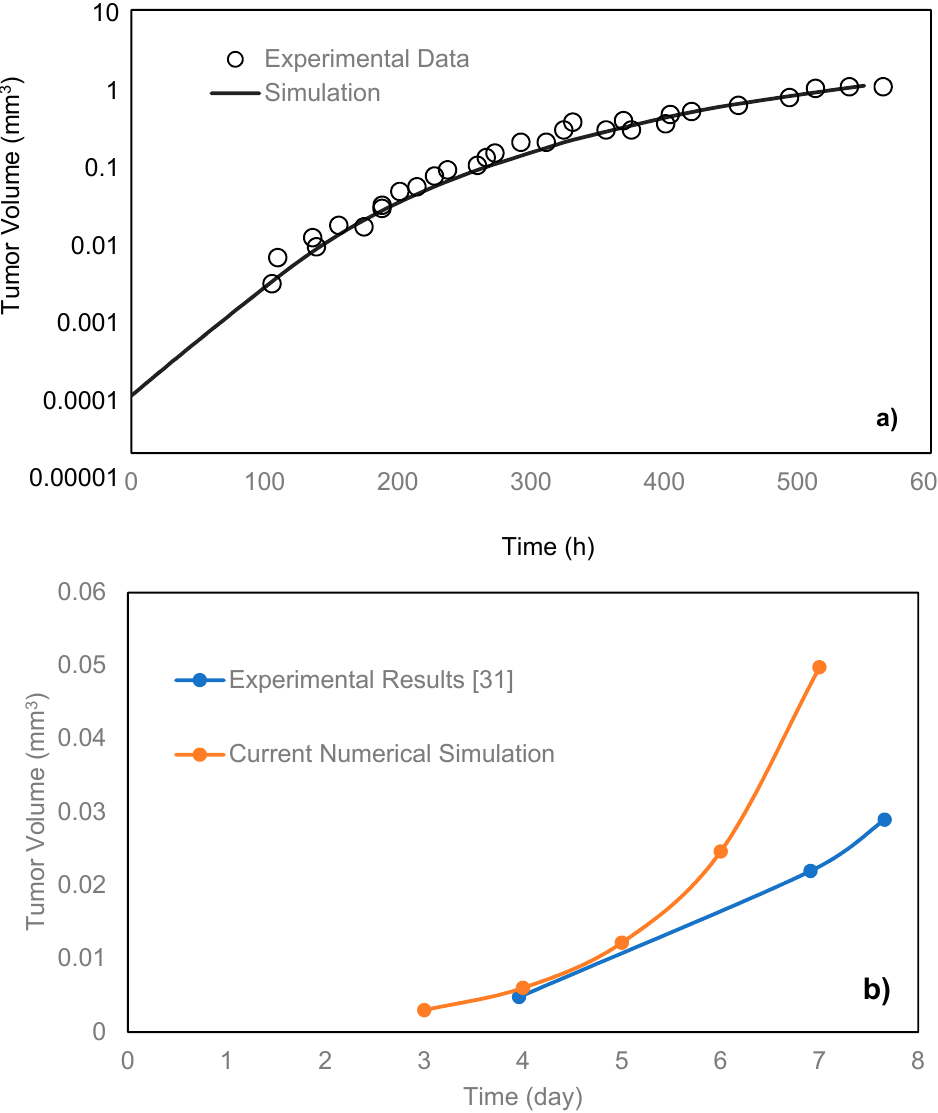
Figure 3. ( a ) Comparison of the tumor volumes from experiment data of the Sutherland and Freyer for EMT6/Ro spheroid [14] and simulation based on the proposed model. In both cases, the tumor is exposed to the unlimited static culture medium, and the glucose and oxygen concentrations in the culture medium are 0.8 mM and 0.28 mM, respectively. ( b ) Applying the model for HT-29 tumor growth in proliferative phase in a microfluidic device with a microwell trap proposed by Zió ł kowska et al. [31]. To better validate the results, on-chip measurements of specific parameters of the HT-29 cell line was necessary. These parameters included the necrosis and apoptosis rates, the diffusion coefficient of the nutrients to the HT-29 tumor spheroids, as well as Michaelis-Menten parameters of the nutrients.